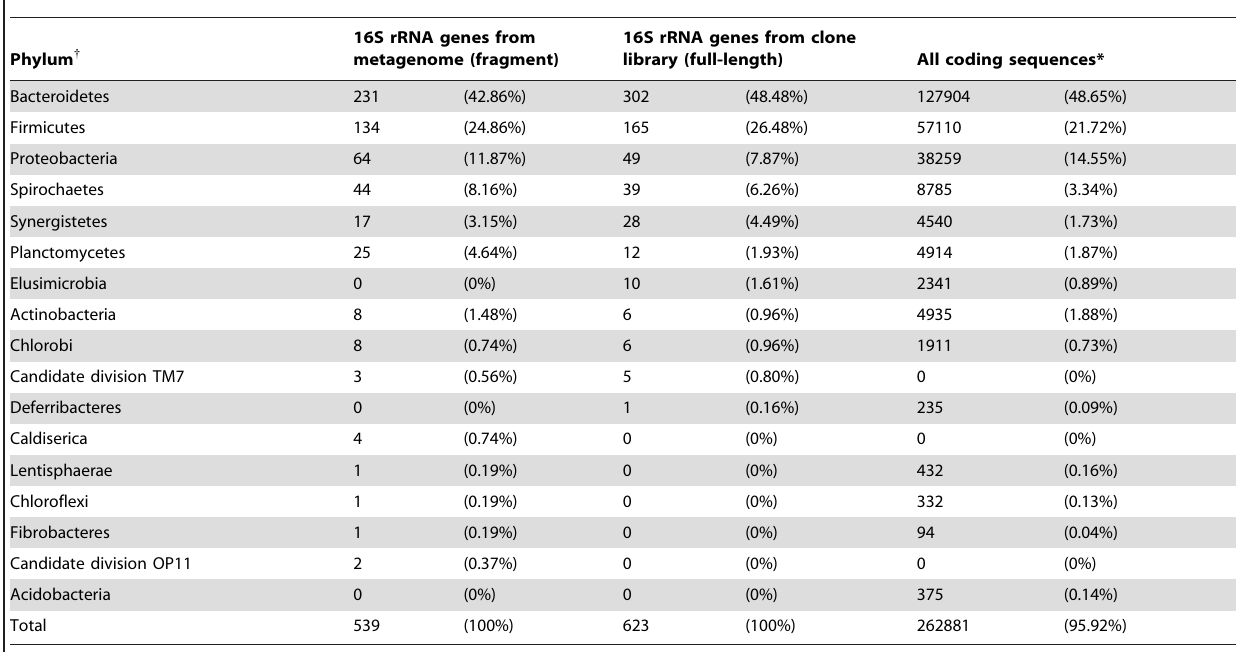
Table 2. Comparison of community composition revealed by 16S rRNA genes and all environmental gene tags.